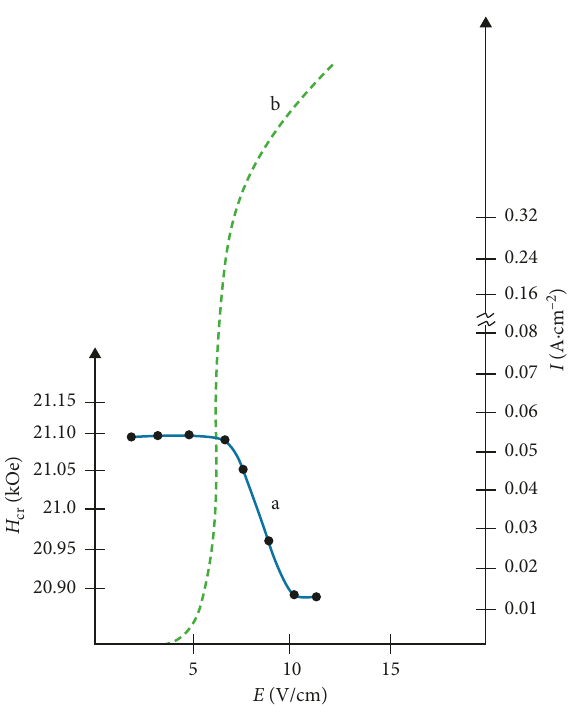
Figure 11: (a) Plasma shift of the resonance magnetic field H dependence on the electric field at T � 4 . 2K with λ ≈ 337 μ m. The curve (b) shows the CVC of the sample in the steady current regime ≪ R ( R S L